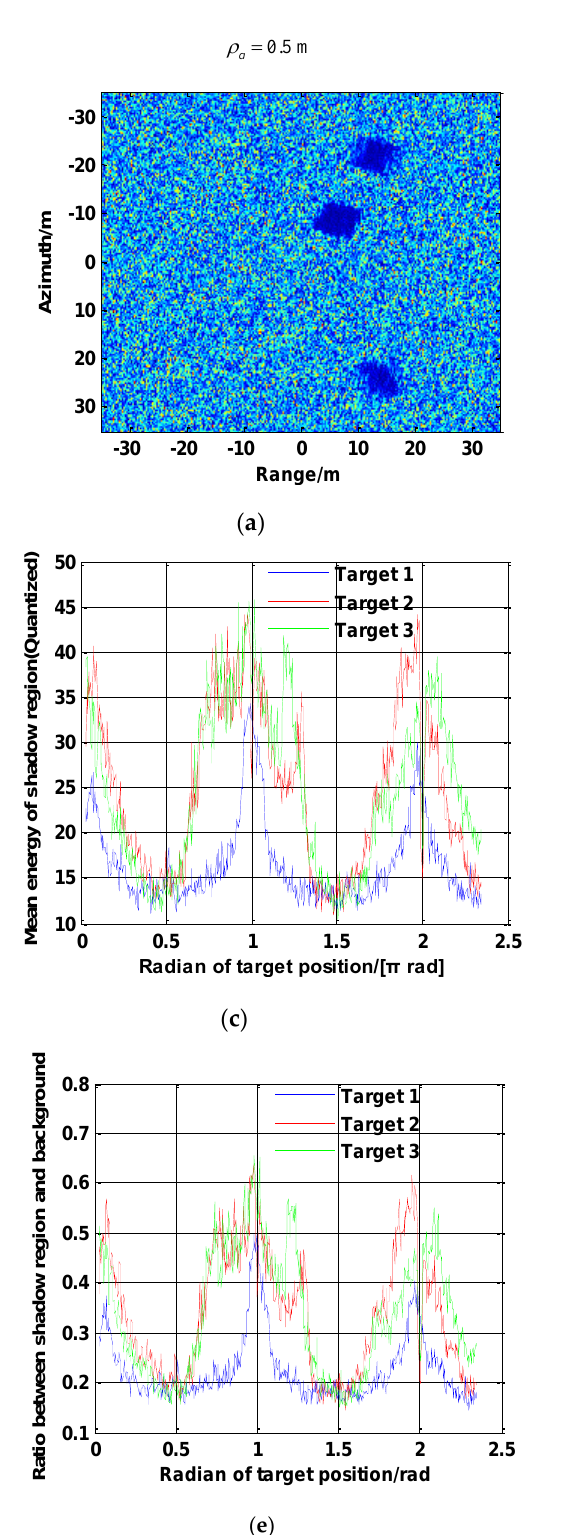
Figure 16. Results of experiment 2. The meanings of ( a–f ) are the same as those of ( a–f ) in Figure 15.